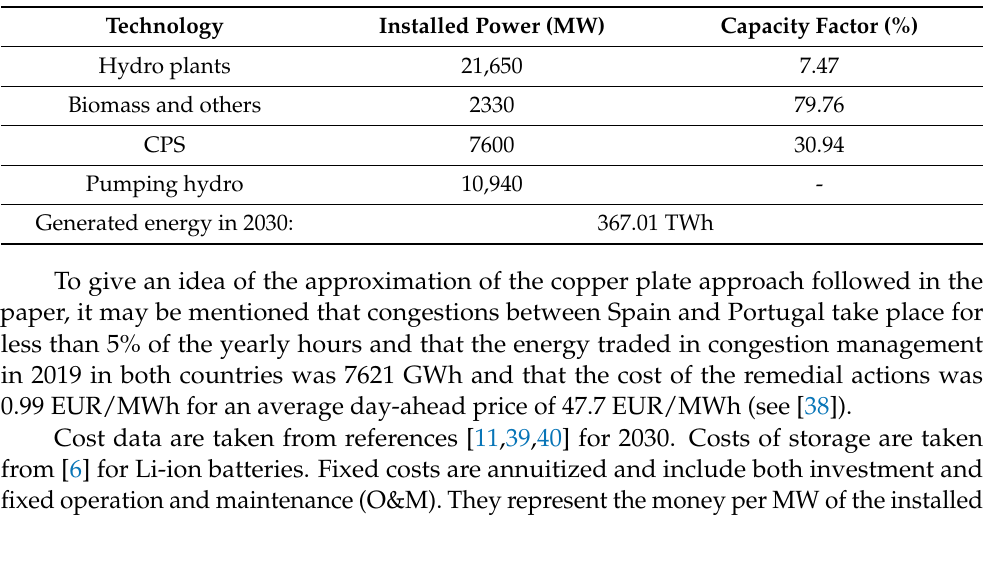
Table 2. Additional technical data - Data from References